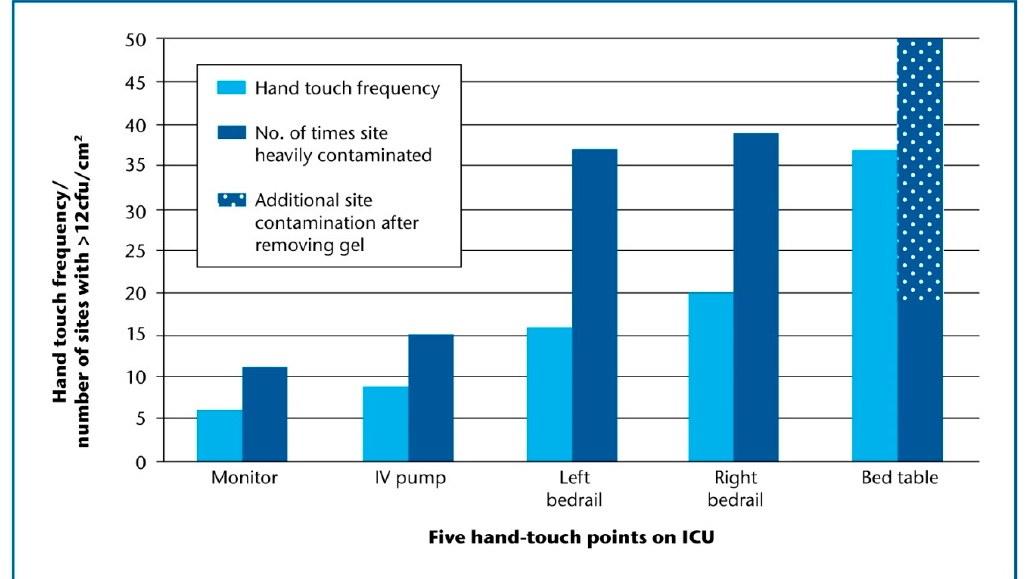
Figure 2. Hand-touch frequency and gross microbial soil for five near-patient sites on ICU. Average hand-touch frequency/site/h following ten observational audits; each site (n = 5) in ten bed spaces was screened on ten occasions; gross microbial soil defined as no. of screens exceeding 12 cfu/cm 2 ; ICU: intensive care unit.